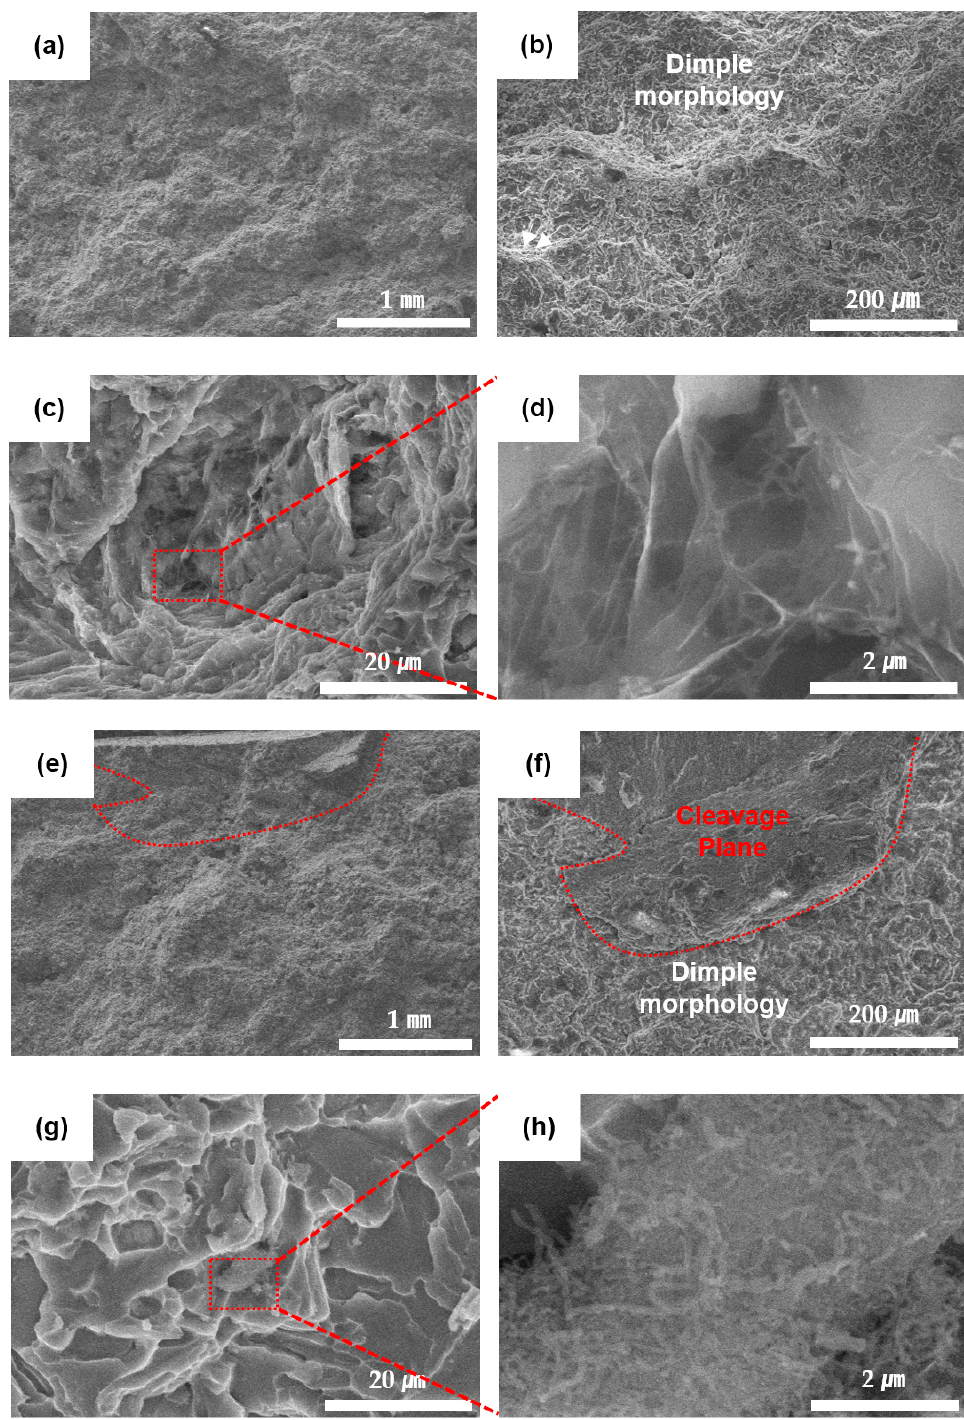
Figure 13. SEM micrographs of fractured surfaces of ( a – d ) 1.0 wt% and ( e – h ) 2.0 wt% CNT-added composites cast using a poly gate by using ORDC. composites cast using a poly gate by using